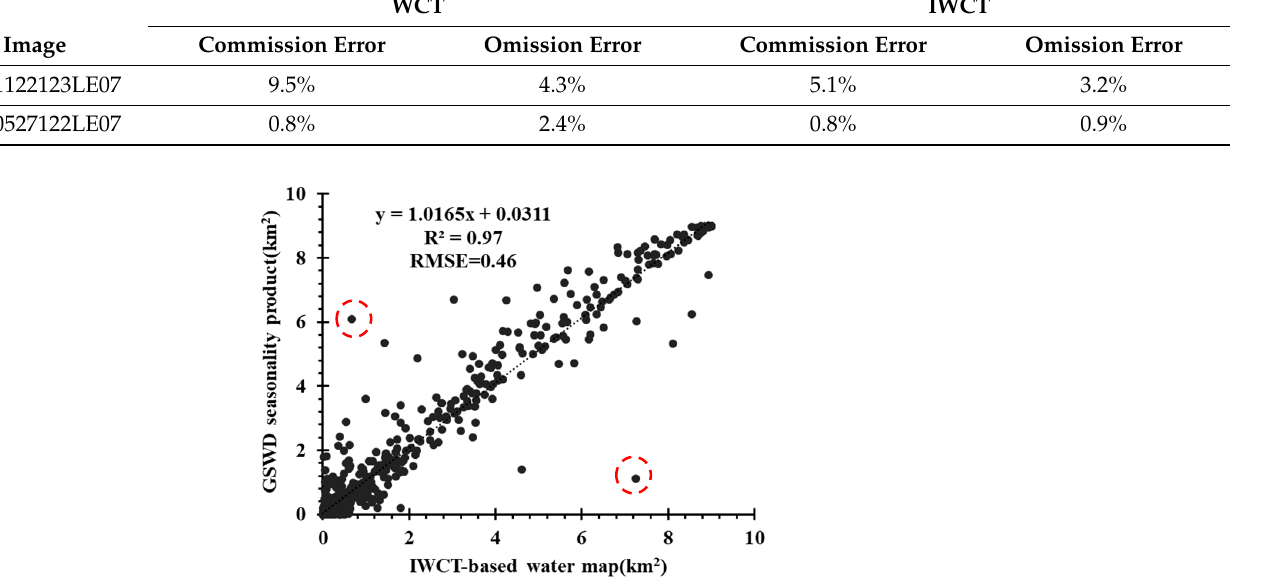
Figure 4. Validation of the IWCT-based water map using existed water bodies image from GSWD seasonality product. The two red circled points showed great differences, and the corresponding water area will be discussed in the Discussion section below.